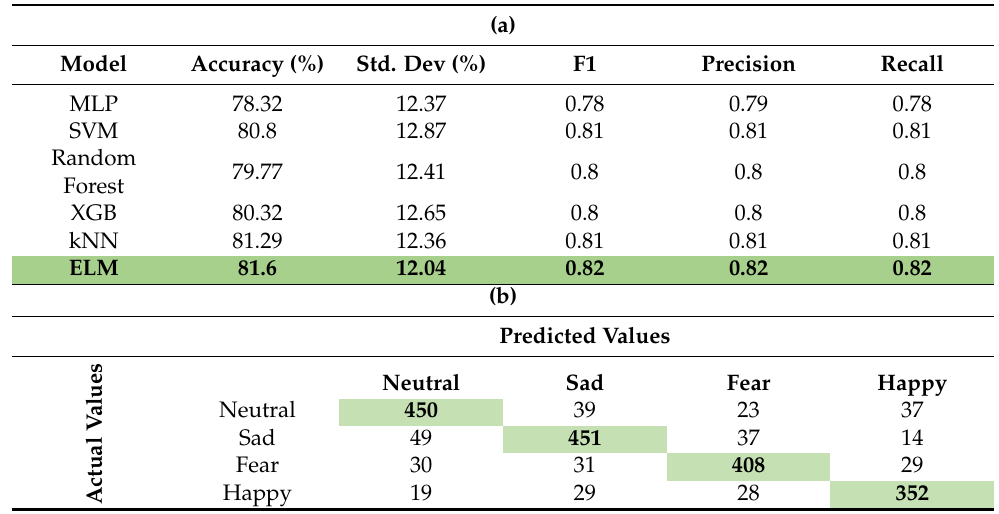
Table 4. ( a ) . SEED-IV (4 classes) results for CNN hybrid models. ( b ). Confusion matrix of 3D-CNN and ELM classifier for SEED-IV